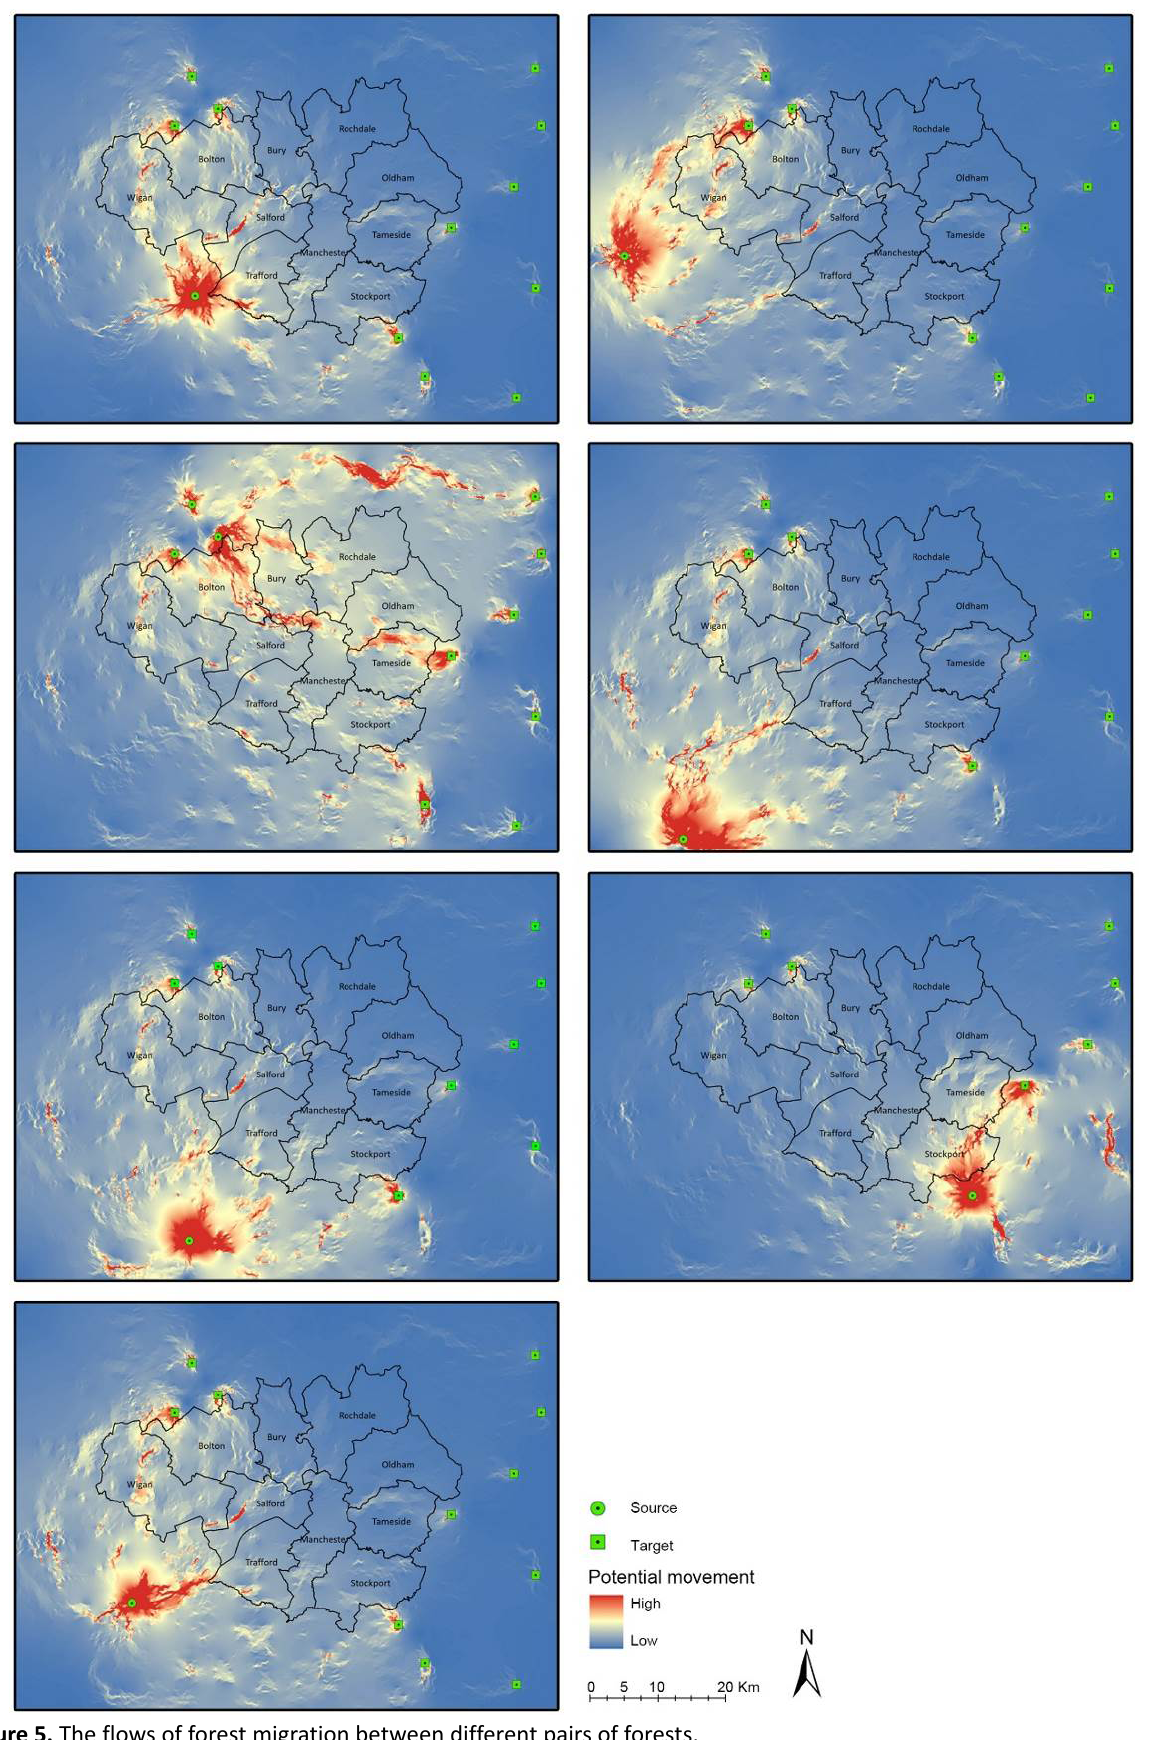
Figure 5. The flows of forest migration between different pairs of